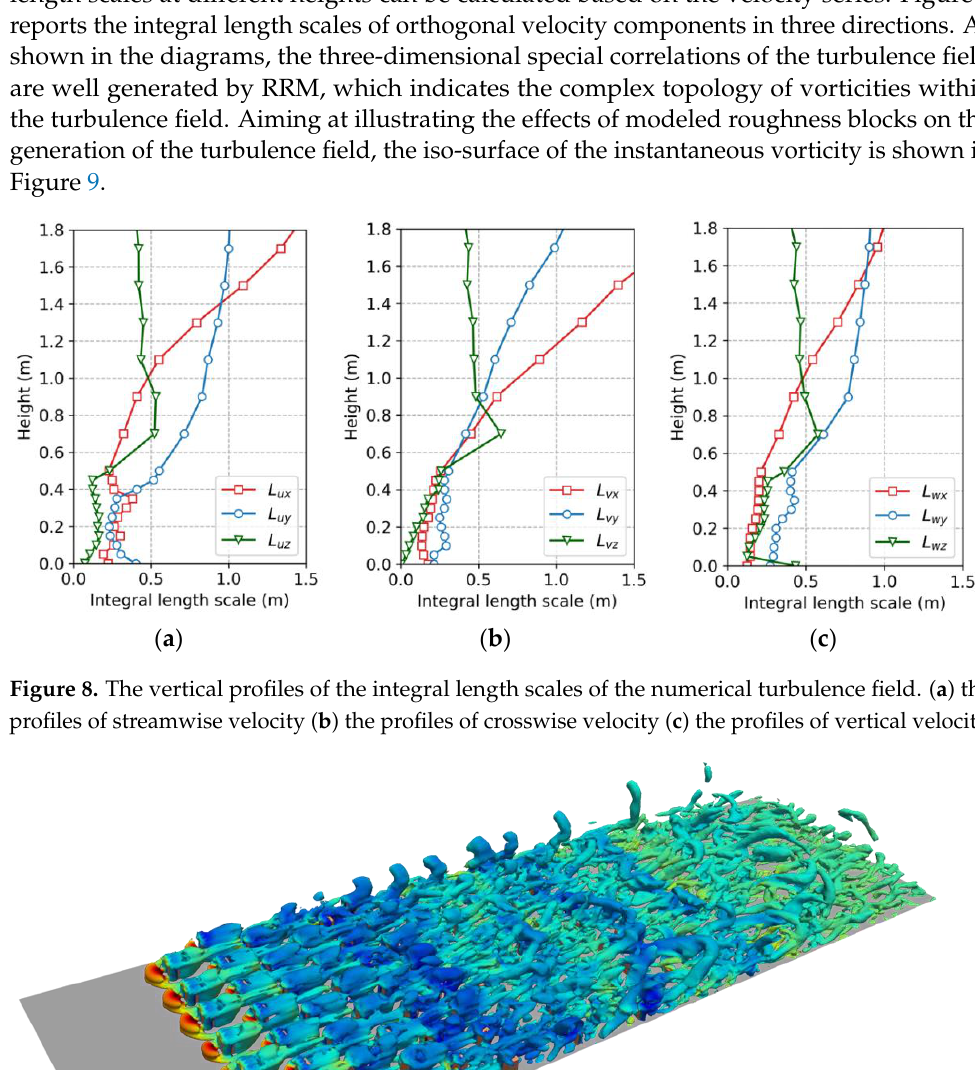
Figure 9. Topology of vorticities over virtual roughness blocks expressed by Q-criterion. The vorti-